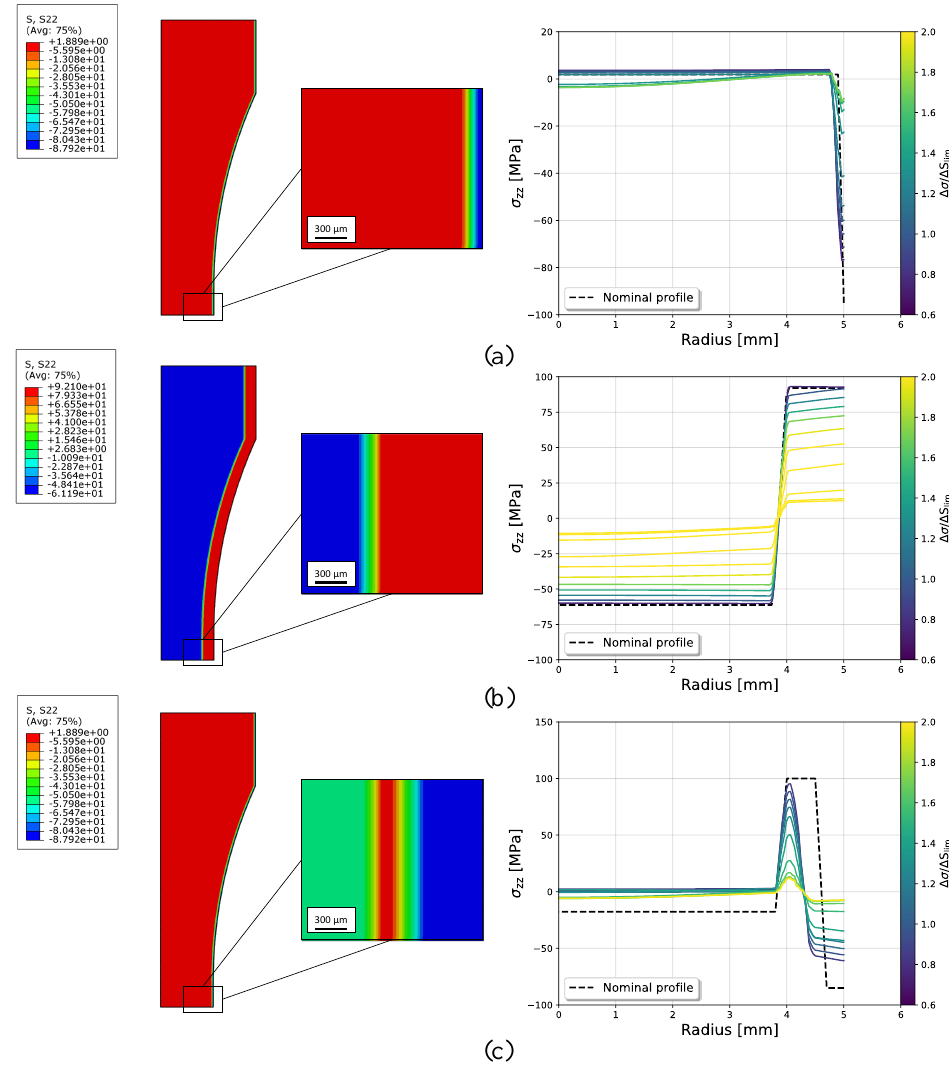
Figure 9. Numerical results of the simulated residual stresses relaxation for the three considered superficial states: ( a ) results of the machined specimens; ( b ) results of the net-shape specimens and ( c ) results of the sandblasted specimens. On the right the residual stresses contours at the beginning of the simulations are reported, on the left their evolution at different stress